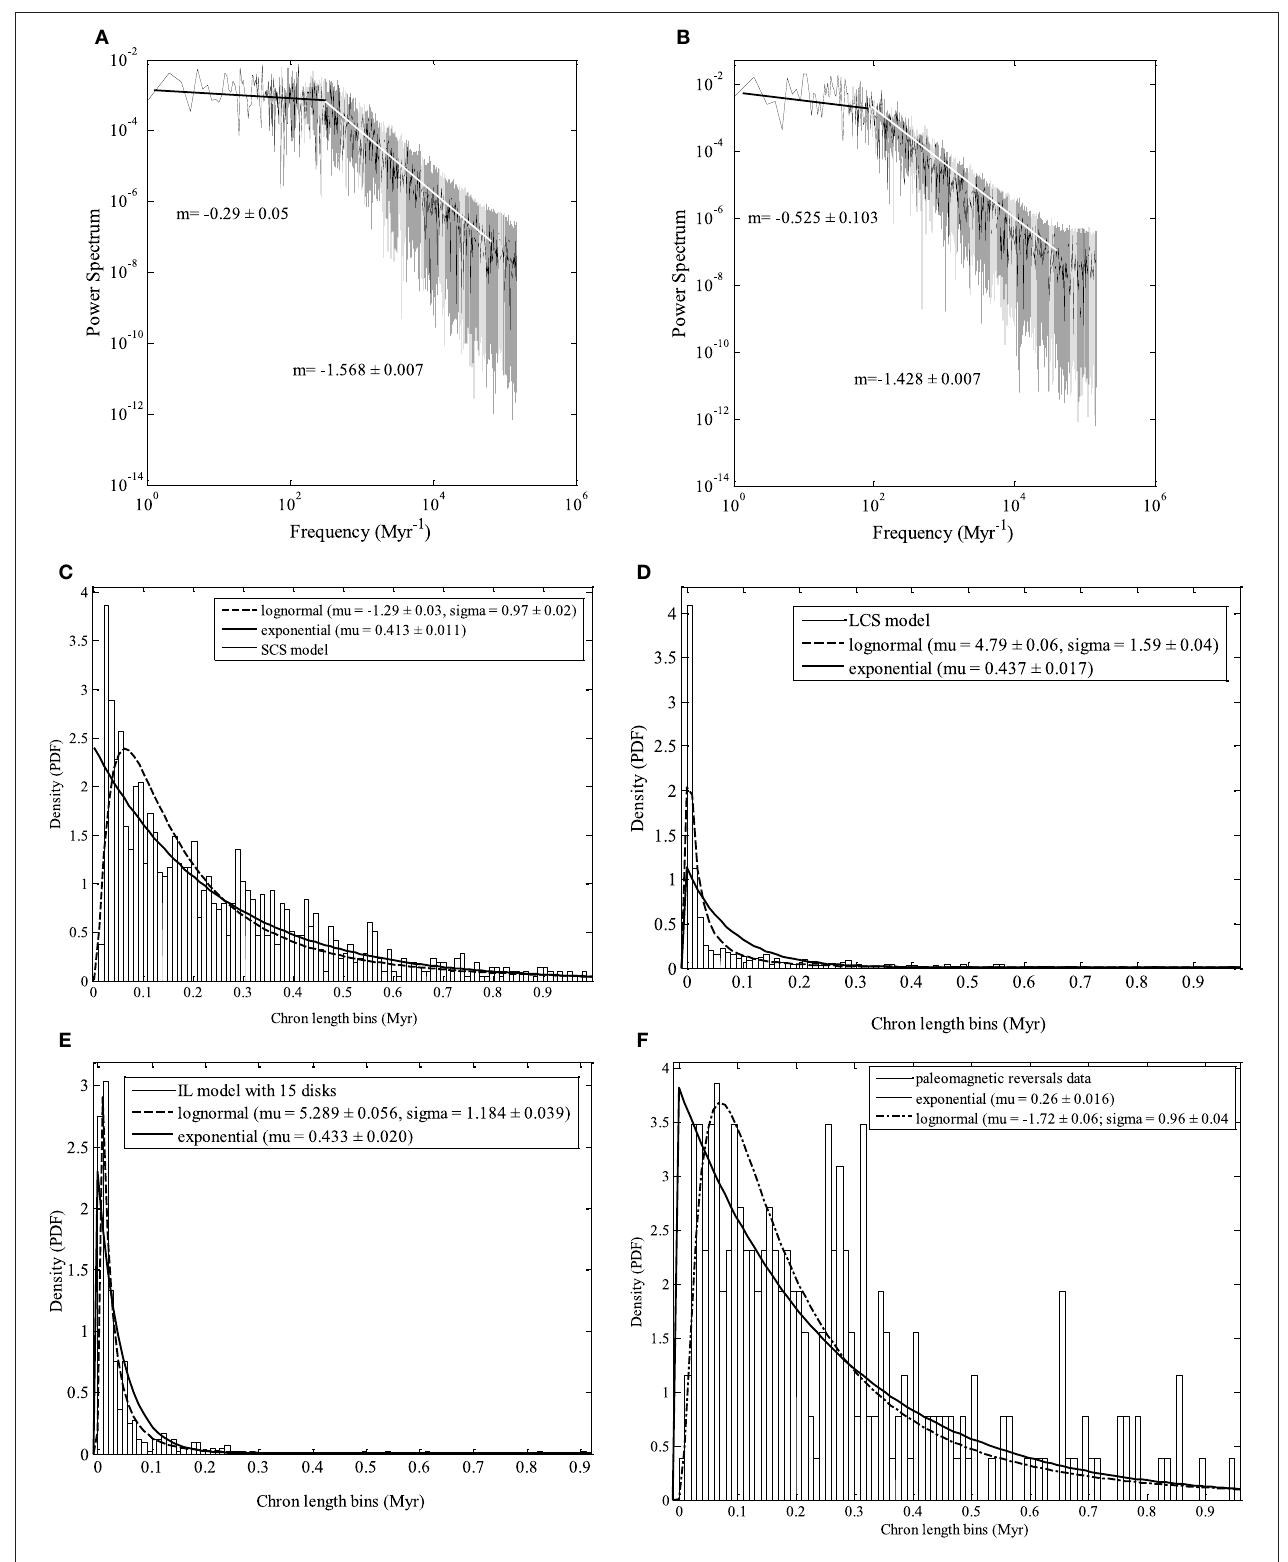
FIGURE 4 | Power spectra density (PSD): of the magnetization series of 300,000 time units generated by (A) SCS model and (B) LCS model with the same values of model parameters; (C) the distribution of chrons length for the SCS model, (D) the distribution of chrons length for the LCS model, (E) the distribution of chrons length of the IL model, (F) the distribution of chrons length of the paleomagnetic time series covering the last 157.53 Myr.